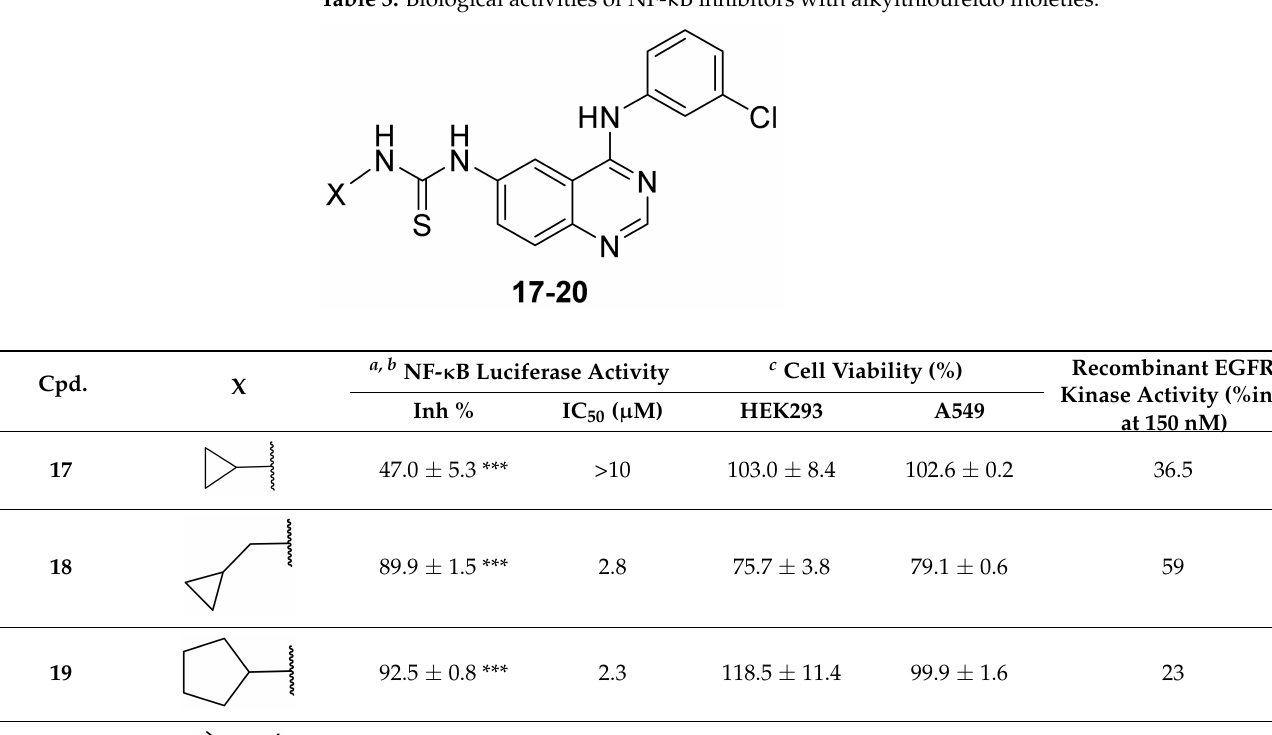
Table 3. Biological activities of NF- κ B inhibitors with alkylthioureido moieties.